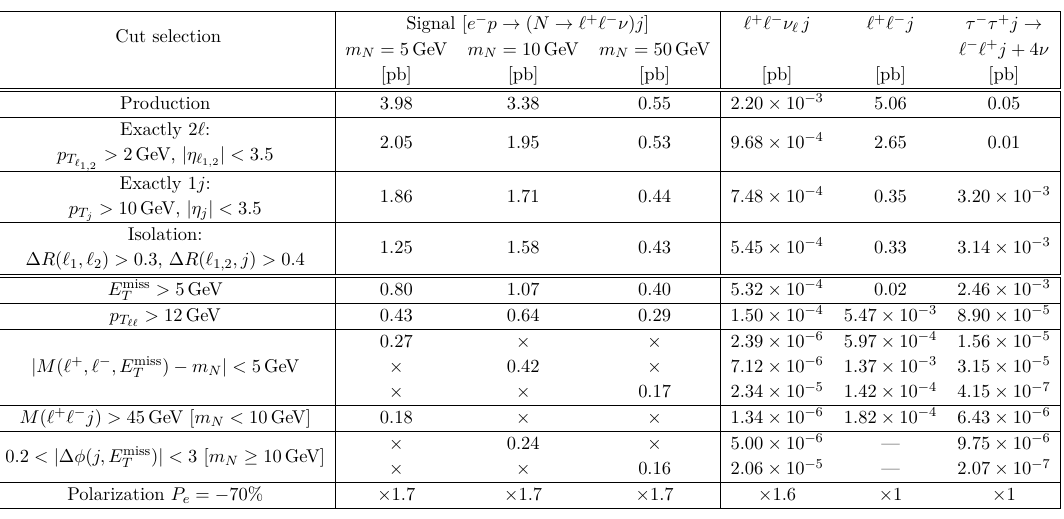
Table 4 . Cut-flow table of the Dirac HNL signal, with | U e | 2 = 1 , and SM backgrounds in the ‘ − ‘ + j + E miss final state. The “–” indicates the background size is T